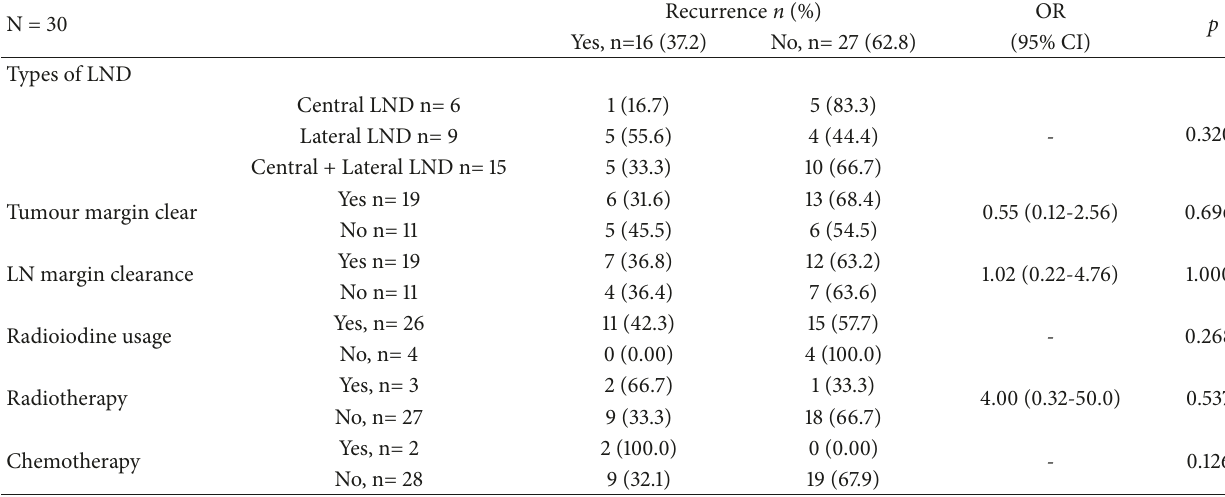
Table 3: Subgroup analysis of those who had recurrence in the 3-year follow-up period among papillary thyroid cancer group (n=30). N = 30